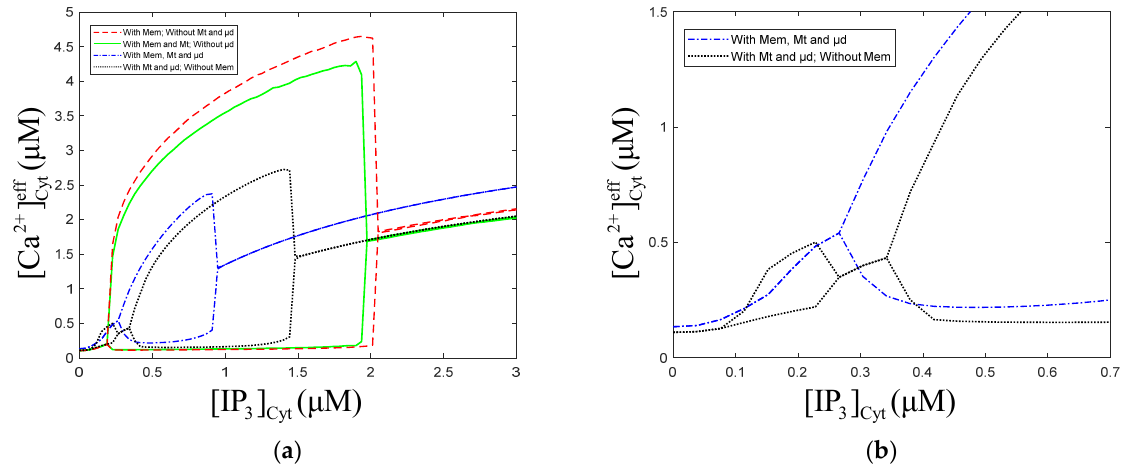
Figure 8. Numerical oscillation analysis diagrams with/without the Mt, µ d and Mem. V PLC = 1 µ M s − 1 , k deg = 1.5 s − 1 ,